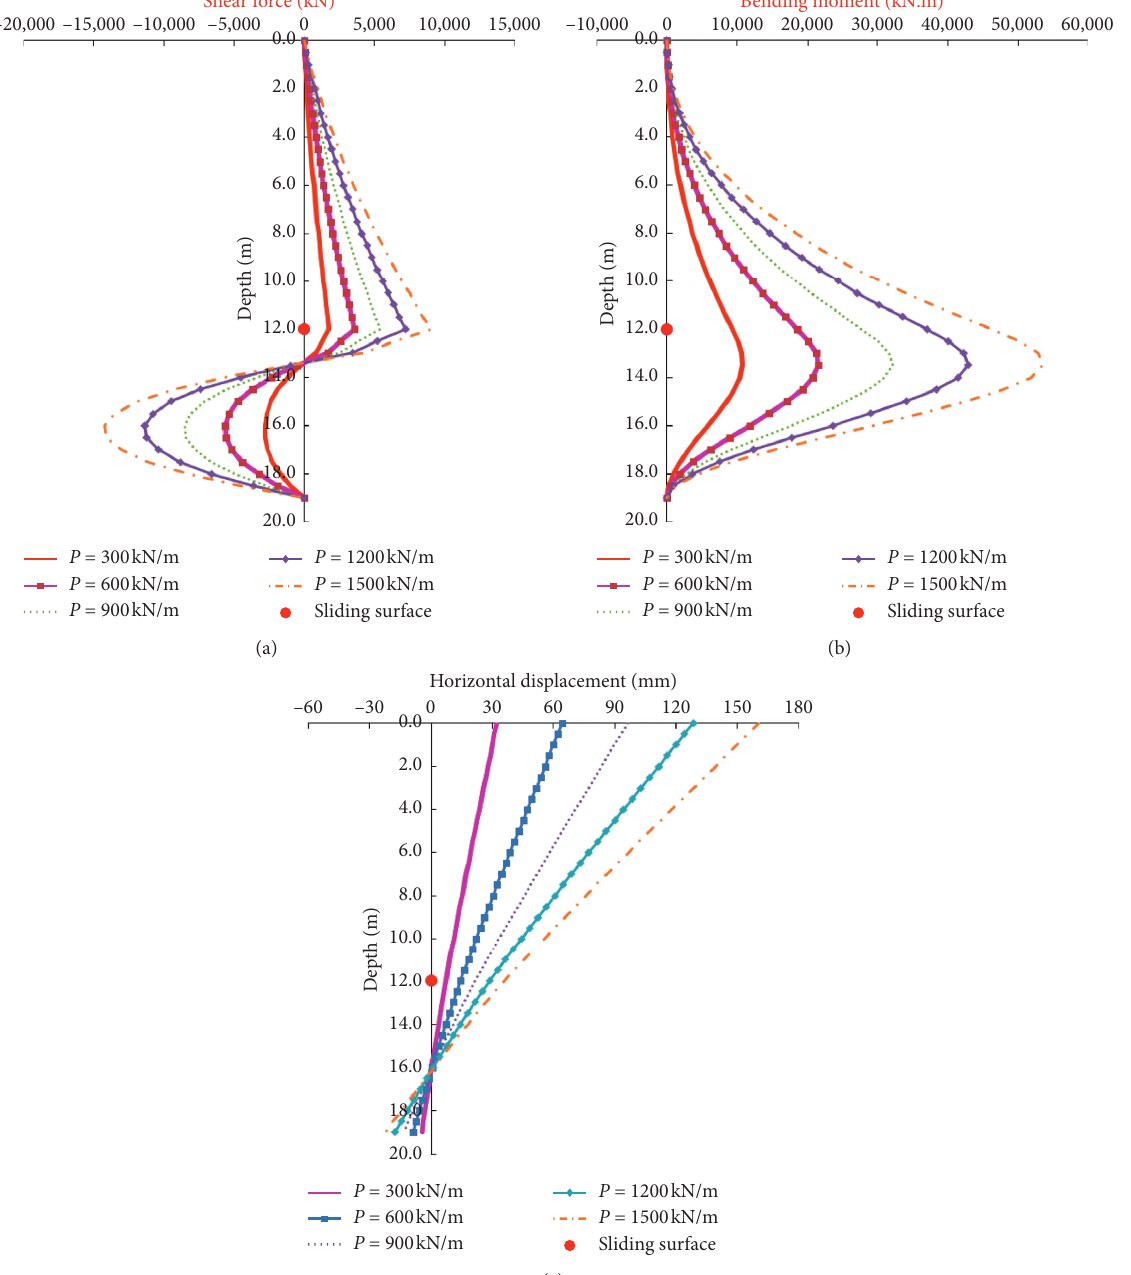
Figure 9: Calculation results of the displacement and internal forces of the pile under the different driving forces of the landslide. (a) Shear force. (b) Bending moment. (c) Horizontal